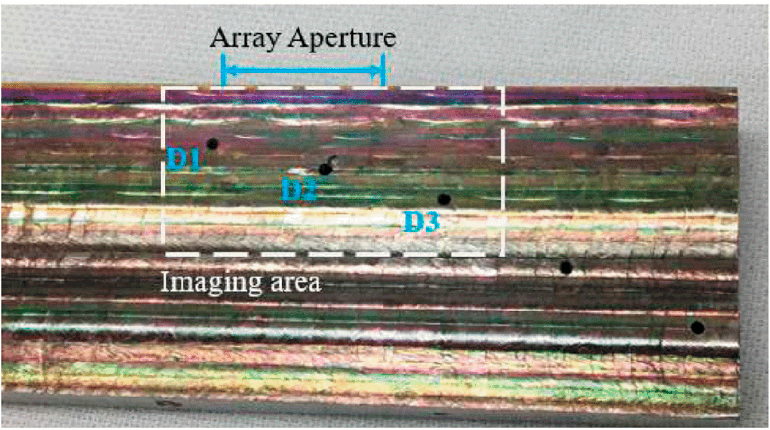
Figure 3. Inspected WAAM component. D1, D2 and D3 represent the welding defects [25].